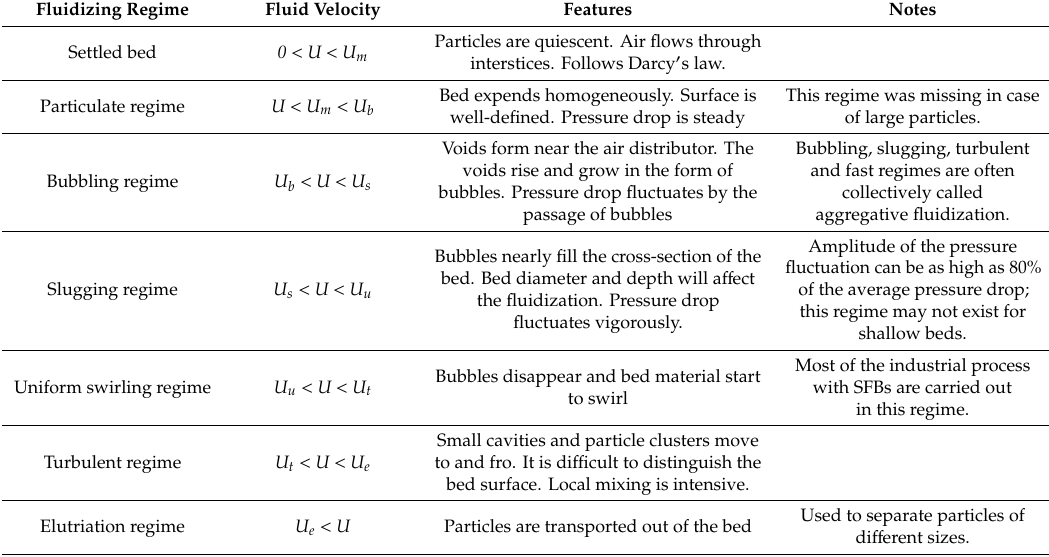
Table 1. Possible regimes of fluidization of a bed as air velocity